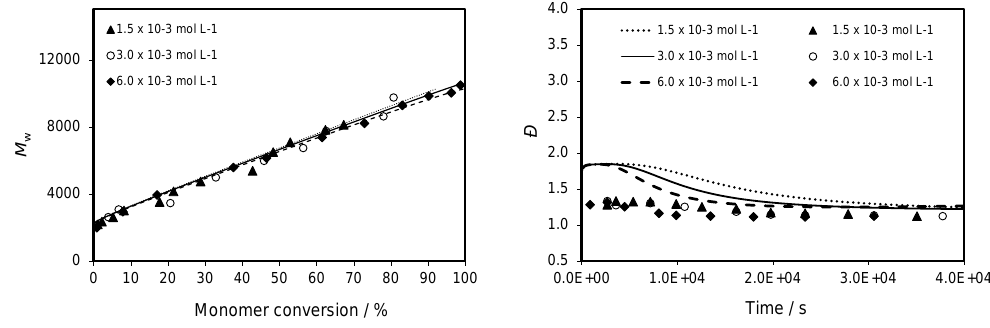
Figure 8. Evolution of M w and Đ versus monomer conversion for CPDB-mediated polymerization of TBDMSMA in toluene at 70 °C with initial concentration of AIBN ranging from 1.5 × 10 −3 to 6.0 × 10 −3 mol·L −1 . The graph compares predicted values (lines) with experimental data (points).